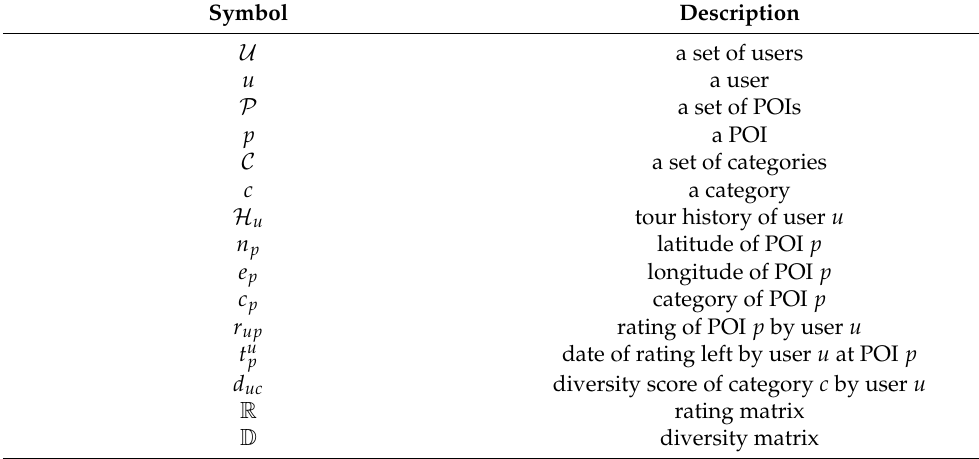
Table 3. Notations.